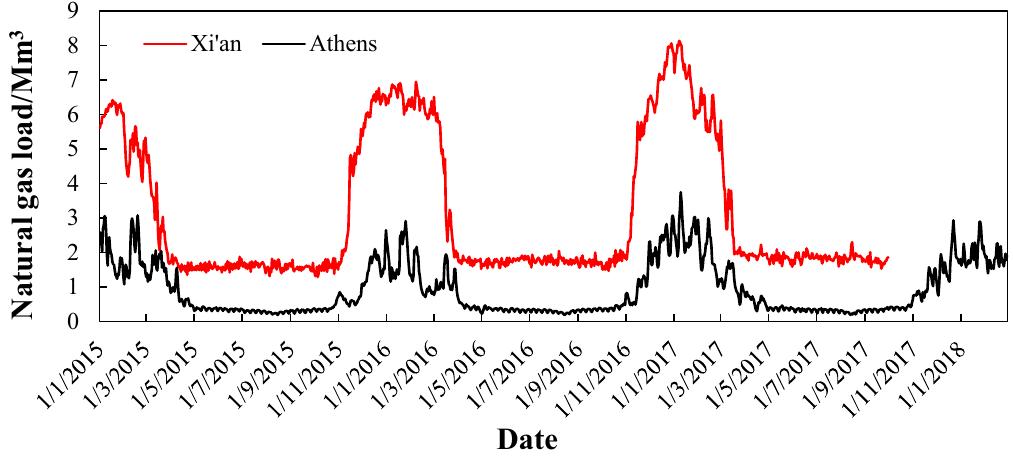
Figure 5. The natural gas loads of Xi’an and Athens.